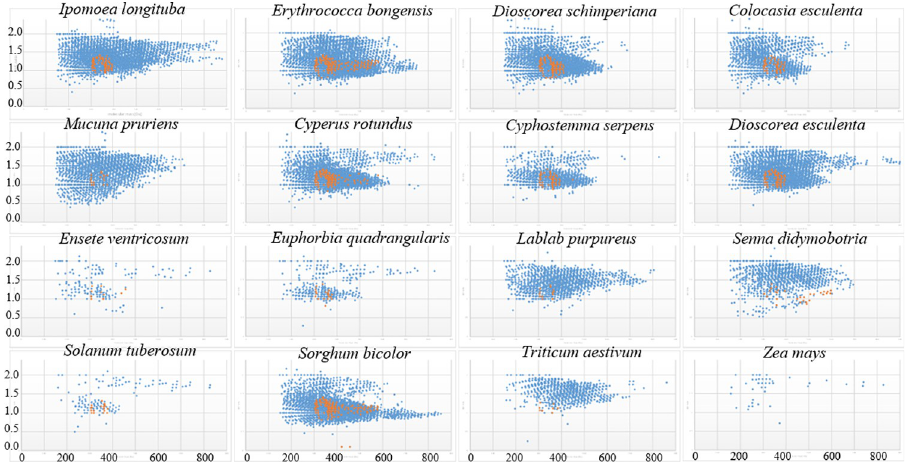
Fig 8. Compositional space for total assigned peaks (blue) and ‘island of stability, IOS’ species (orange), shown as H / C ratio versus molecular mass. IOS species defined as H / C ratio (1.04–1.3), molecular mass: 300–600